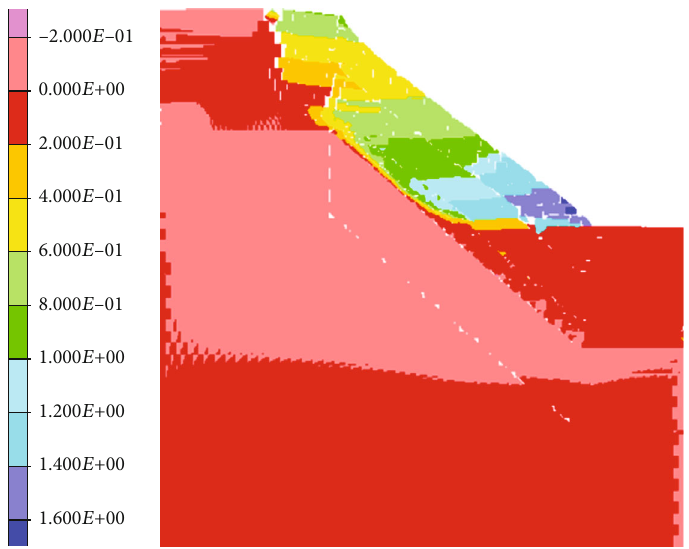
Figure 10: Displacement cloud diagram in the xx direction when running 160,000